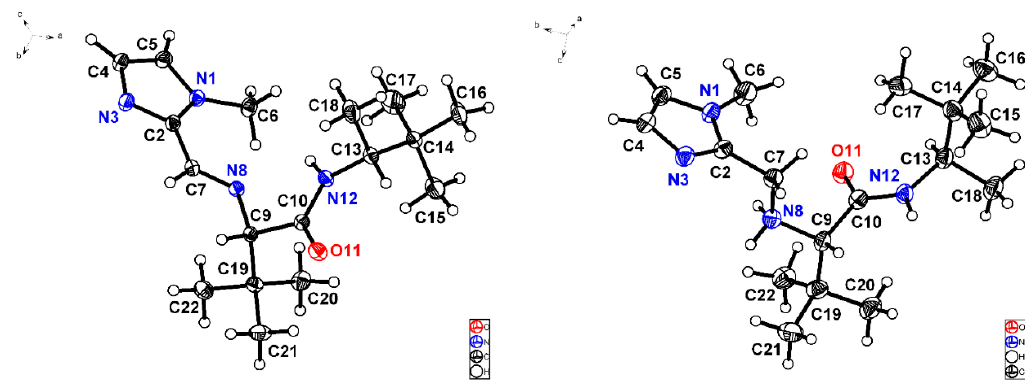
Figure 5. X-ray structures corresponding to imine ( S , R )- V -(d) [C10-N12 1.336 (2) Å, C10-O11 1.227 (2) Å] (left) and ligand L10 [C10-N12 1.335 (6) Å, C10-O11 1.238 (5) Å] (right) depicted with ellipsoids at 30% probability.